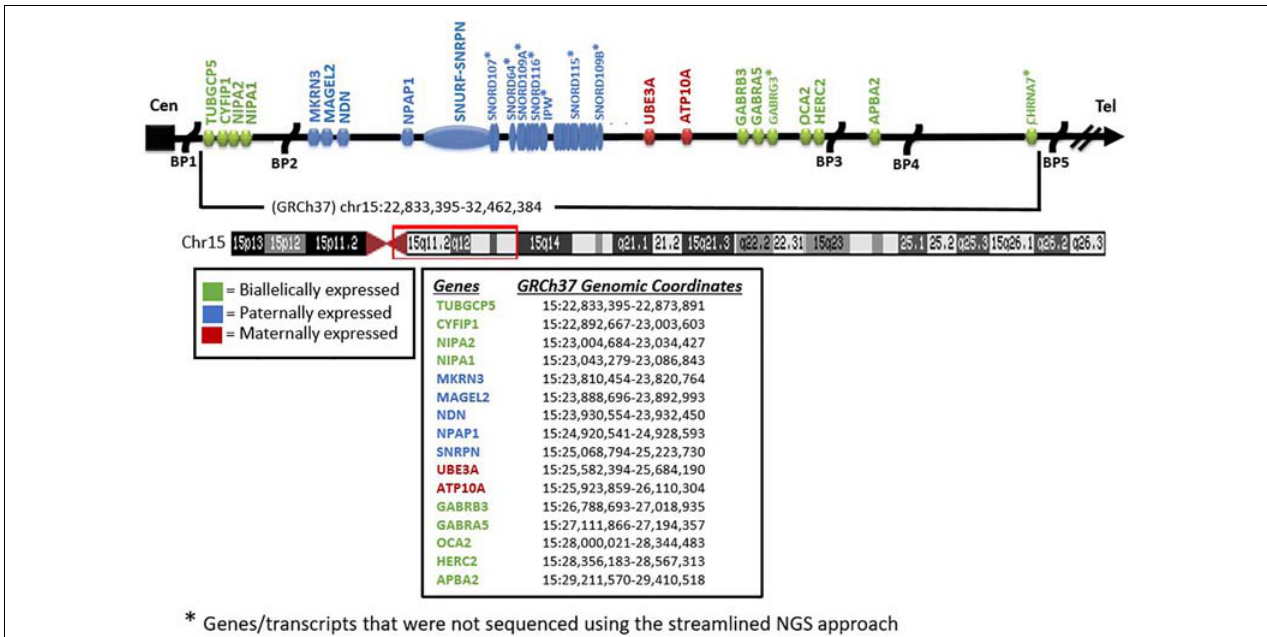
FIGURE 1 | Chromosome 15 ideogram. Genes and previously reported breakpoints (“BP”) in the 15q11-q13 region are shown in their relative genomic positions. Genes not marked with asterisk were sequenced by the whole-exome sequencing test performed.